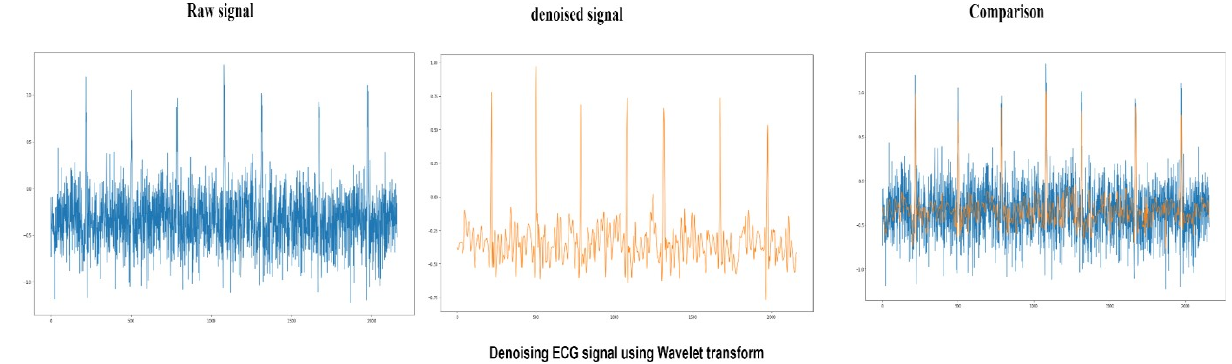
Figure 6. Raw ECG signal (Blue) denoised using wavelet transform and comparison between denoised signal (Orange) and raw signal.